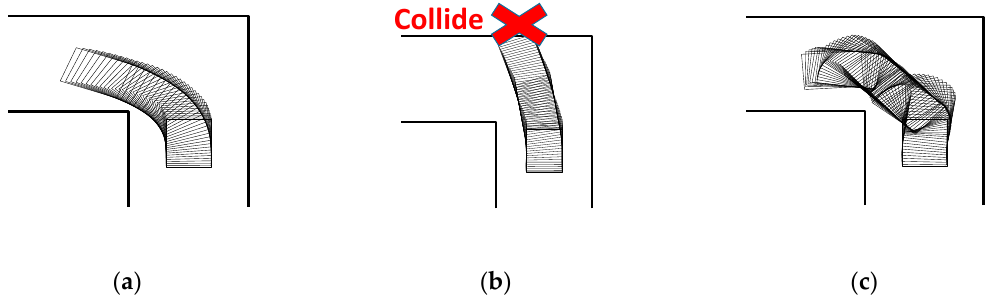
Figure 13. Driving examples with different input characteristics: ( a ) normal user, ( b ) user with insufficient input, and ( c ) user with oversteered input.